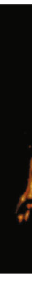
Figure 2: 3D reconstruction CT imaging from right posterior view shows the origin of the right pulmonary artery from the right subclavian artery (white arrows) and the left-sided PDA (asterisk). The stenosis of the RPA is also